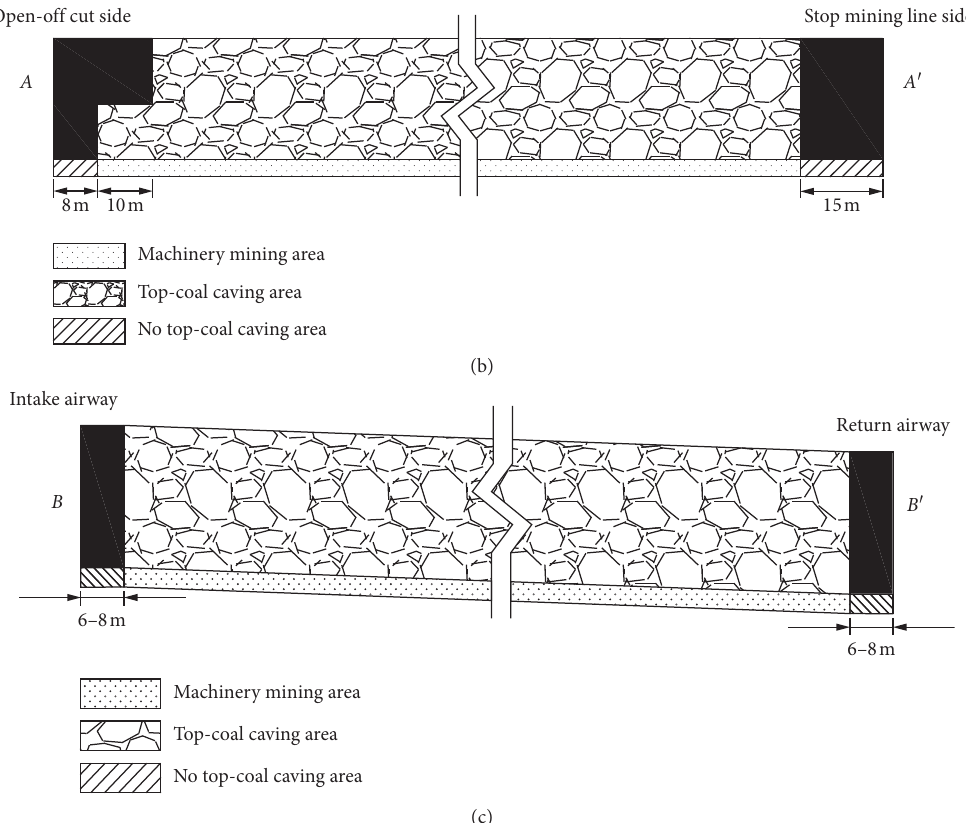
Figure 2: Top and cross-sectional view of the caving situation. (a) Top view. (b) Cross-sectional view of line AA ′ . (c) Cross-sectional view of line BB ′ .